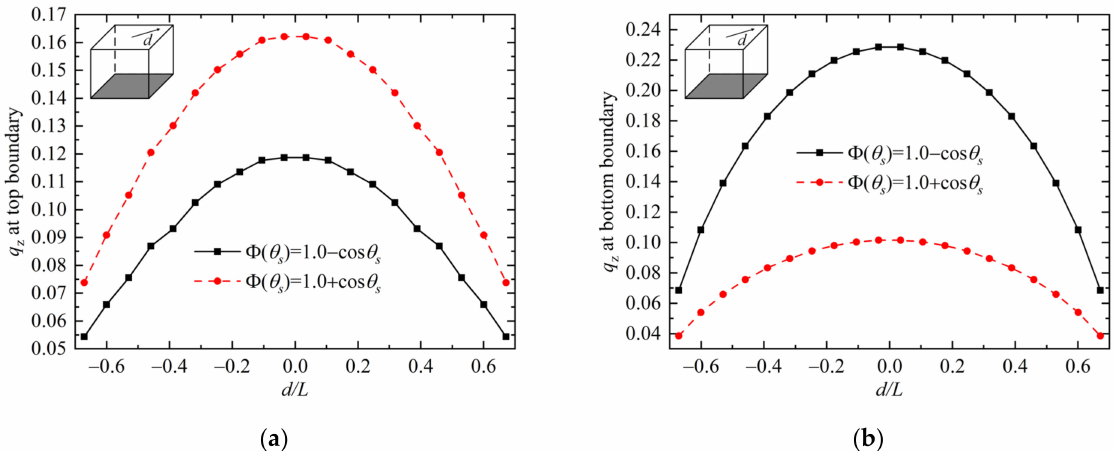
Figure 8. Heat flux with different scattering phase functions in Case 1: ( a ) results at top boundary; ( b ) results at bottom